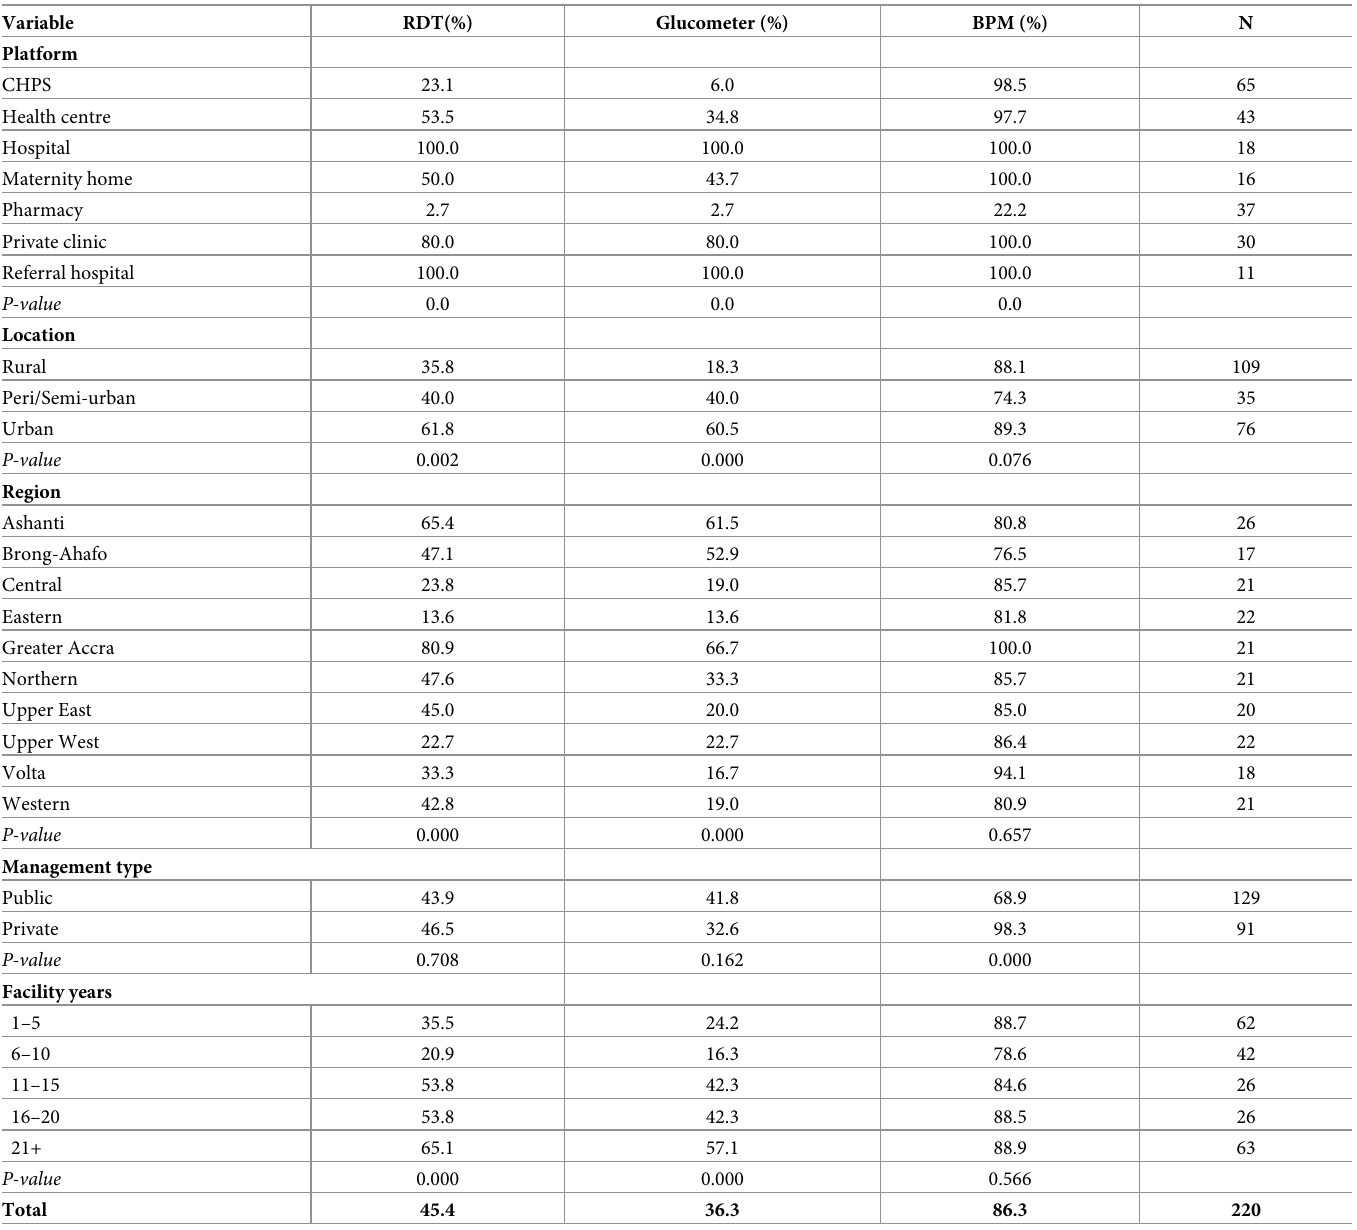
Table 3. Availability of RDT, glucometer and blood pressure monitor by facility characteristics,